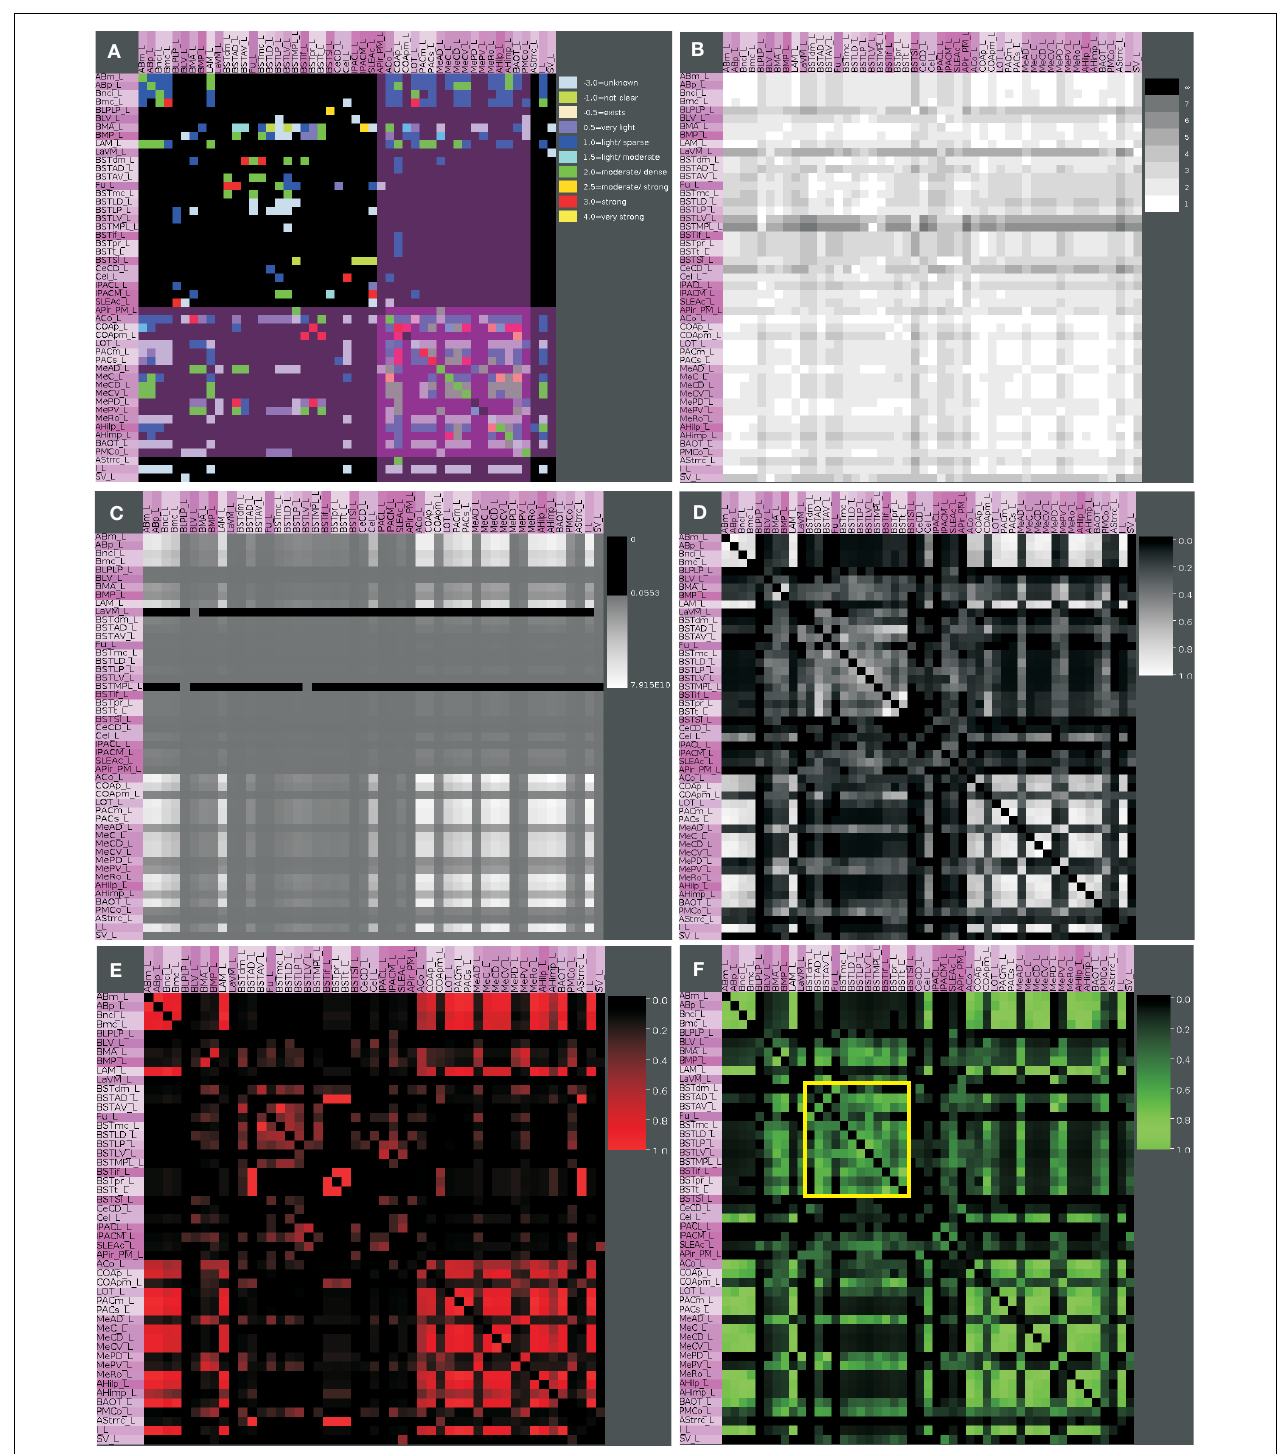
shortest paths between a pair of regions exist. (D) Connectivity matching matrix for inputs and outputs.The gray level scale is coding values between 0 and 1. Large values indicate similar input and output connections of two regions. (E) Connectivity matching matrix for inputs. Red shades are coding similar inputs of two regions. (F) Connectivity matching matrix for outputs. Green shades are coding the similar outputs of two regions.The yellow square indicates the regions of the bed nucleus of the stria